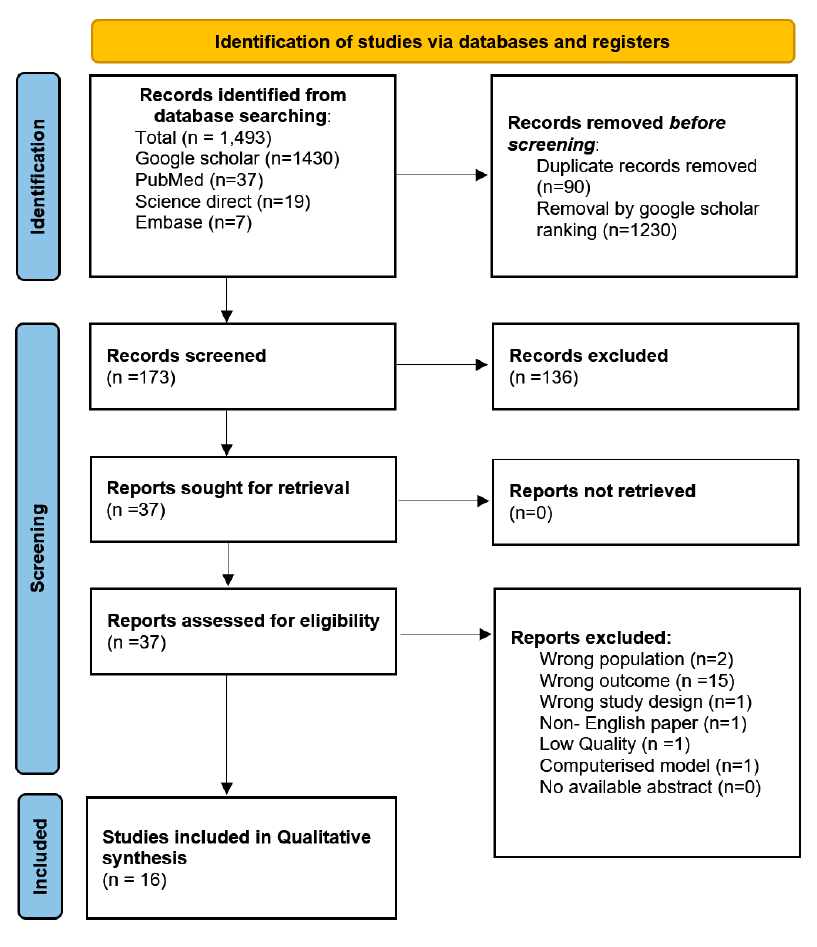
Figure 1. PRISMA flow diagram.